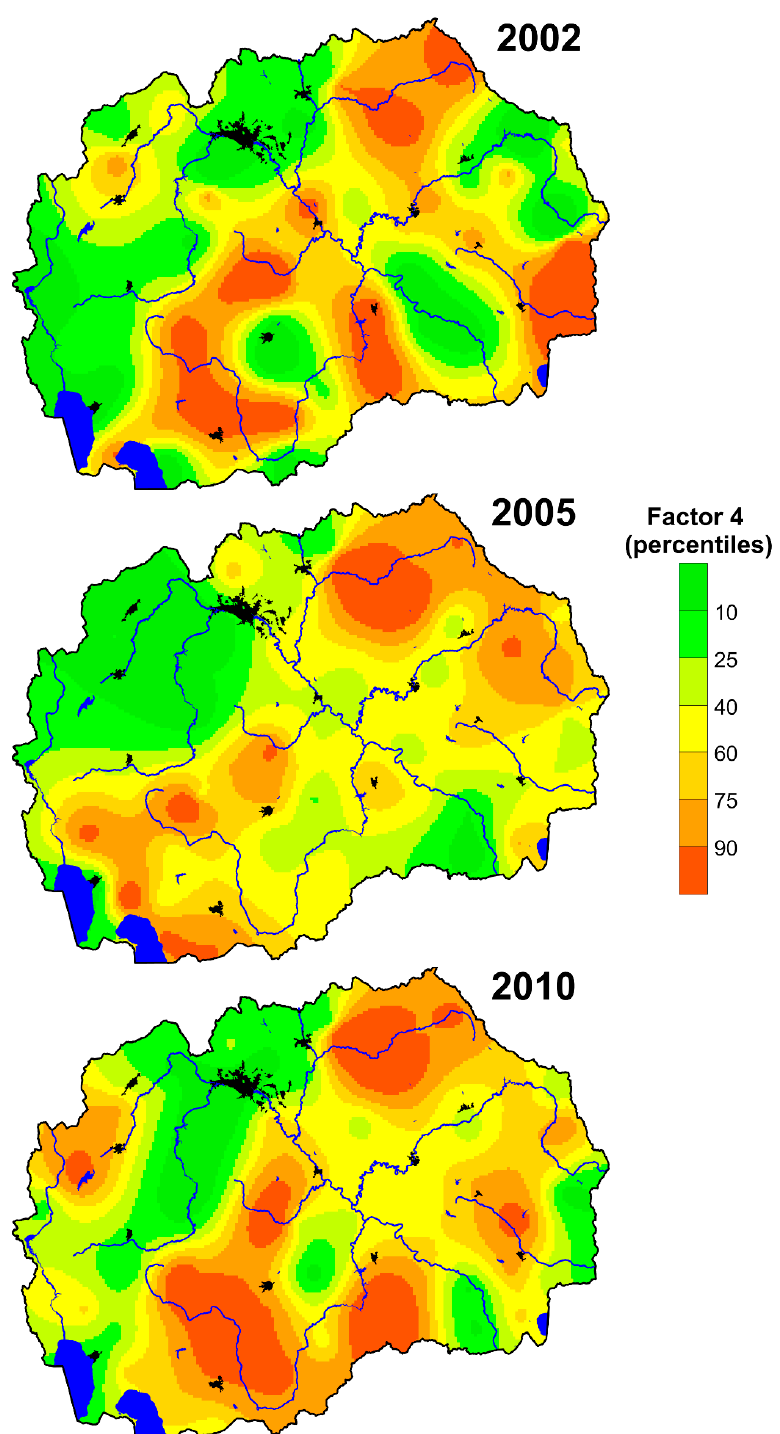
Figure 9. Spatial distribution of F4 factor scores (Ba-K-Sr).